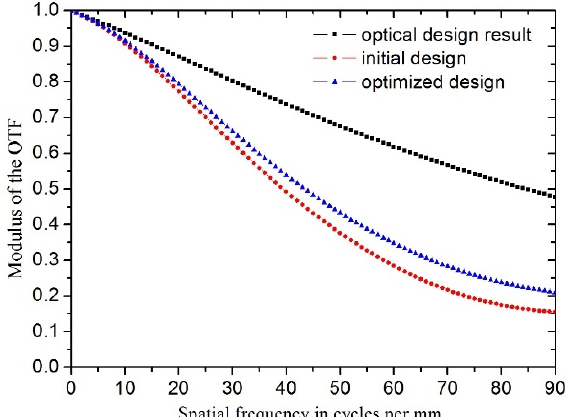
Figure 9. Comparison of the modulus of the OTF (MTF, 0° field angle) curves of initial and optimized design under 30 °C uniform temperature decrease.